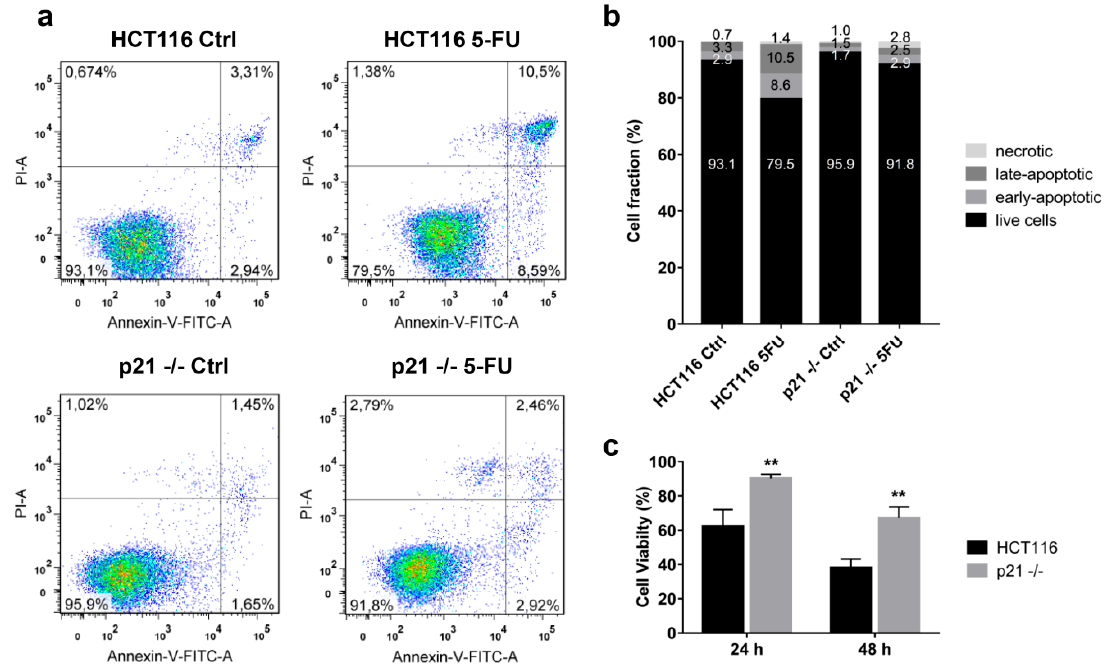
Figure 4. Susceptibility of HCT116 wild-type (HCT116) and HCT116 p21 knockout (p21 − / − ) colorectal cancer cell lines towards 5FU treatment. ( a ) Effects of 5FU (10 µ M) on the induction of apoptosis and necrosis in HCT116 and p21 − / − cells after 48 h of incubation as assessed by the Annexin-PI assay. The experiment was carried out in technical and biological duplicate. One representative experiment is shown. ( b ) Fractions of live, early-apoptotic, late-apoptotic and necrotic cells in 5FU-treated and control HCT116 and p21 − / − cell populations as determined from the Annexin-PI assay after 48 h of incubation. Values of one representative experiment are shown. ( c ) Cell viability of HCT116 and p21 − / − cells after treatment with 5FU (10 µ M) for 24 h and 48 h with respect to DMSO controls. Values represent means ± SD of three independent experiments. ** p < 0 . 01.